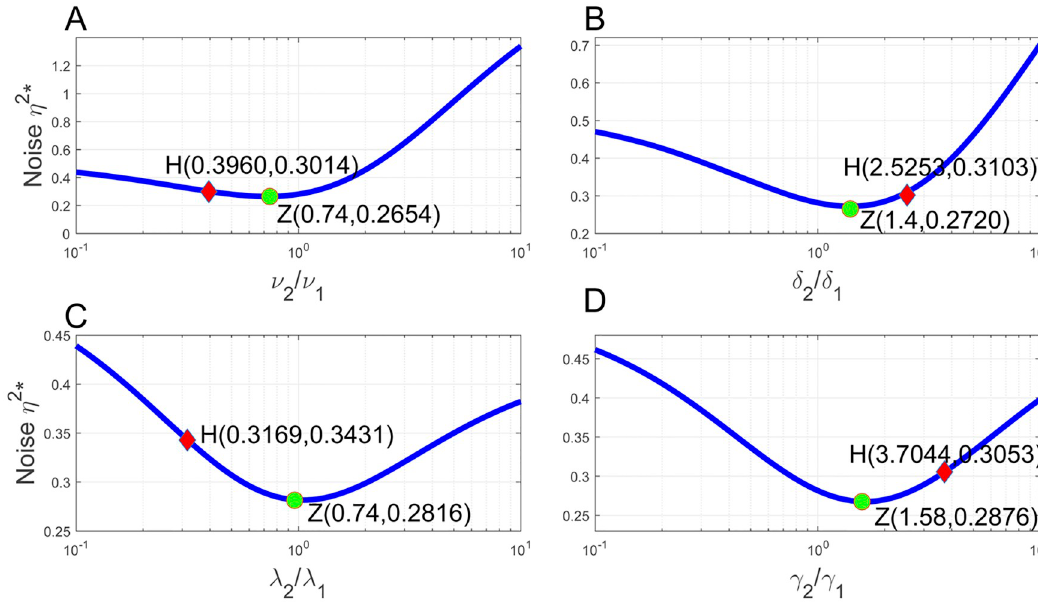
Fig 6. Transcription homeostasis nearly minimizes transcription noise. The ratios ν 2 / ν 1 , δ 2 / δ 1 , λ 2 / λ 1 , and γ 2 / γ 1 increase from 0.1 to 10 in (A)-(D), whereas other parameters are kept as in (51) and (58). In (A)-(D), the point H at which transcription homeostasis is reached and the noise minimizing point Z stay very